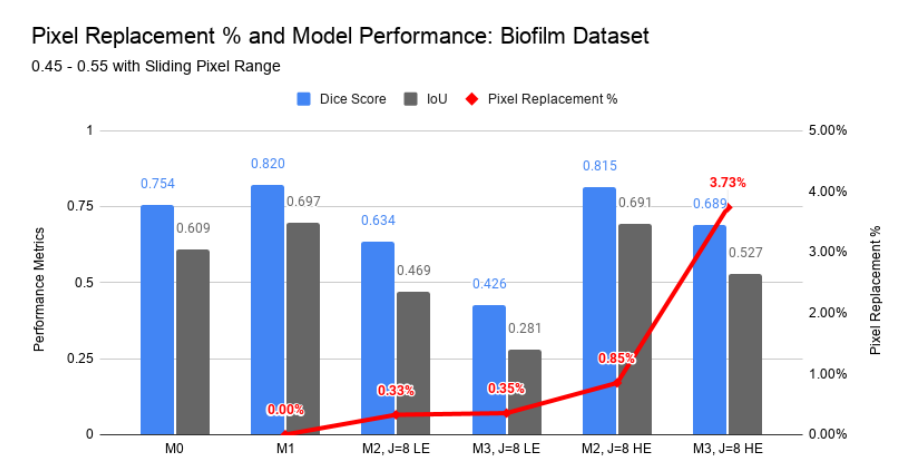
Figure 8. Performance on the biofilm dataset using the SSPA approach with HE pixel label replacements.